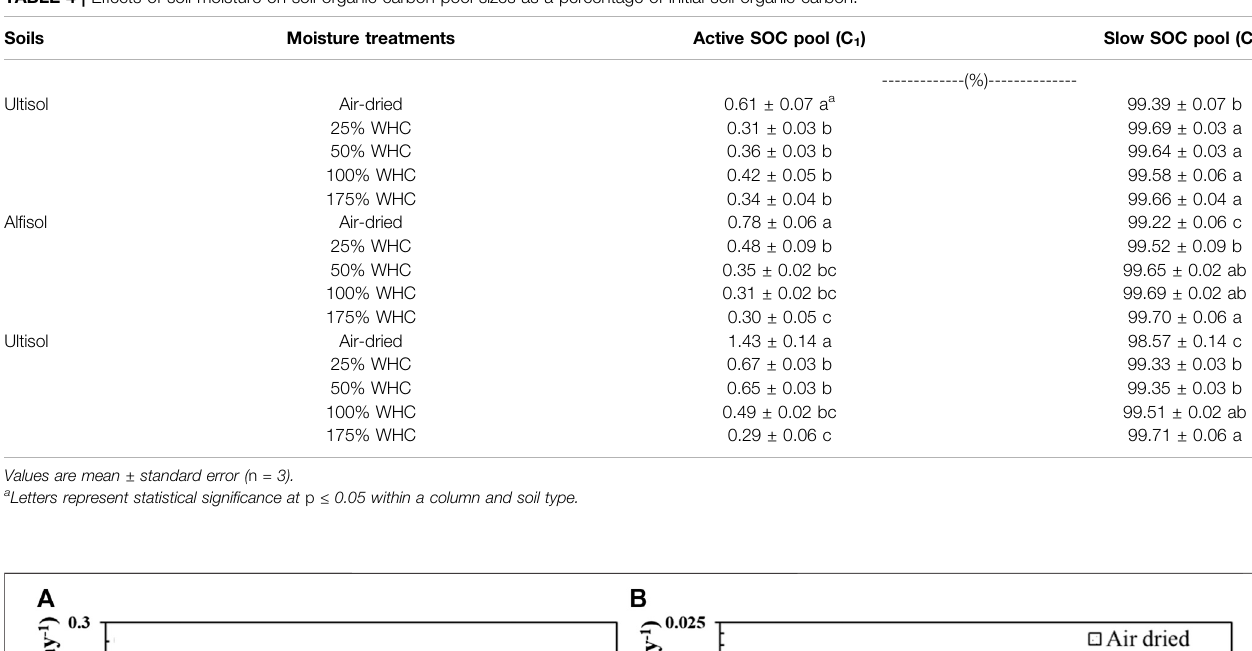
TABLE 4 | Effects of soil moisture on soil organic carbon pool sizes as a percentage of initial soil organic carbon.